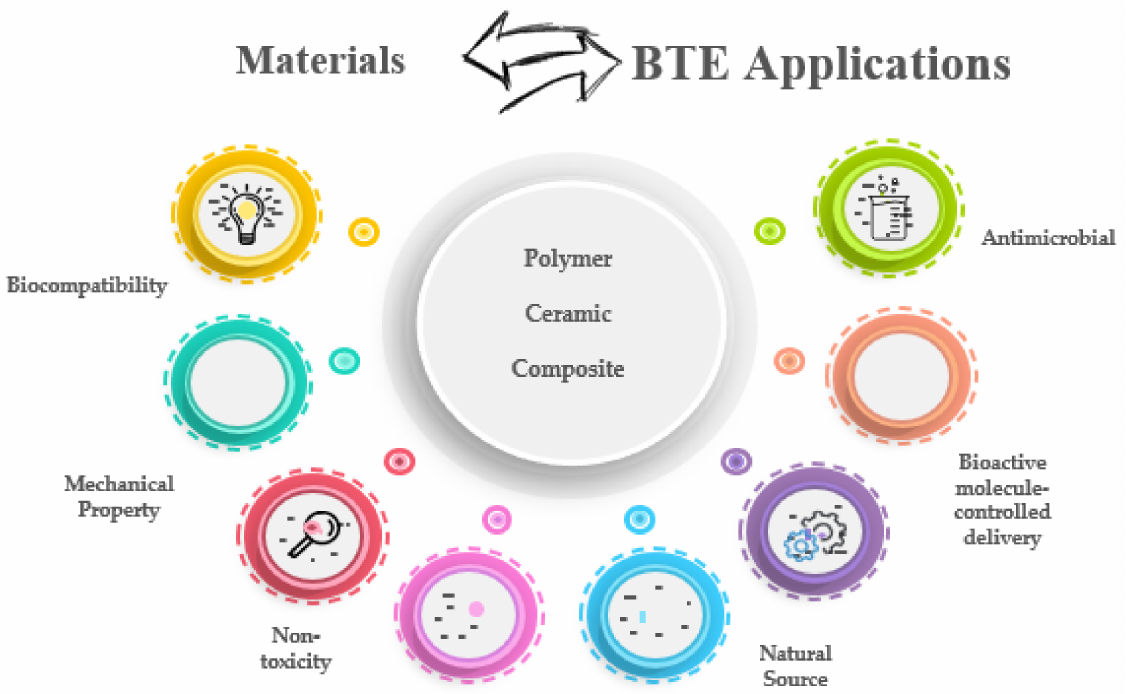
Figure 1. Schematic representation of the relationship between materials and necessary properties for BTE